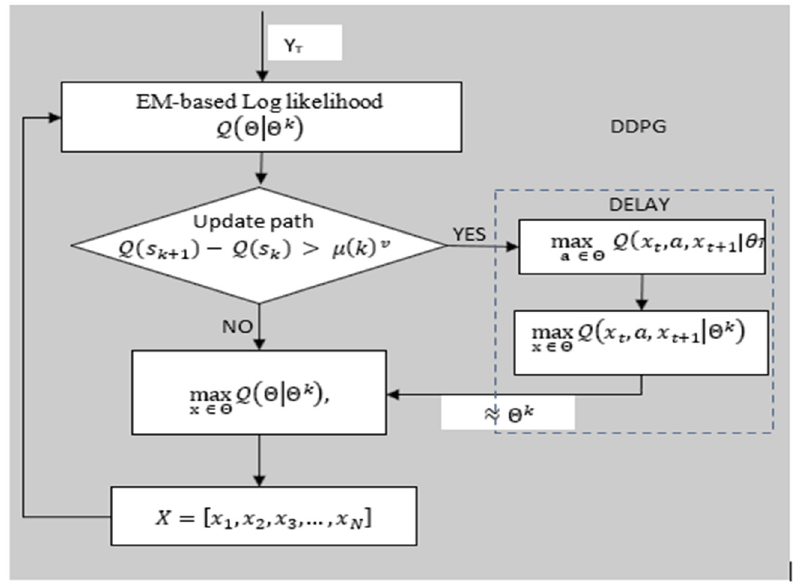
Figure 4. Workflow of JMLS–DDPG algorithm.